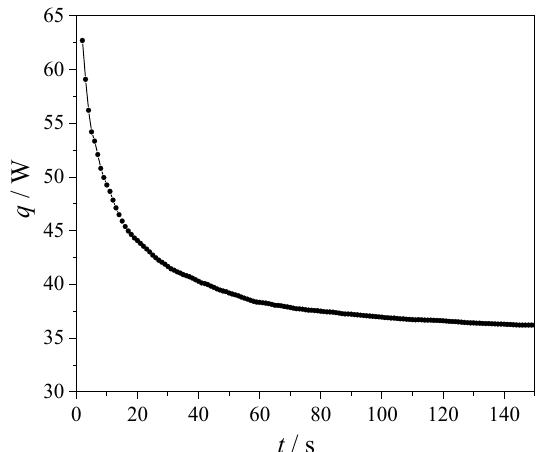
Figure 4. Variations of heat flux with time for the particle flow around a circular tube ( v out = 0.5 mm / s, d p = 1.72 mm).